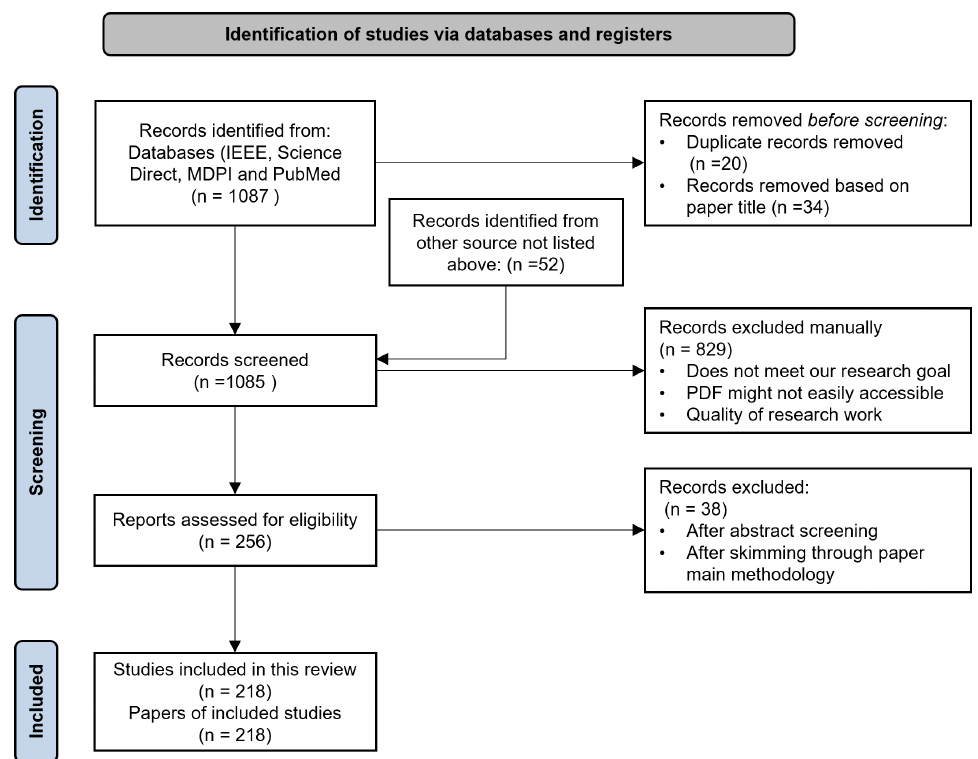
Figure 2. PRISMA Analysis of articles searched: Flow diagram for study collection and reviews, which included searching databases